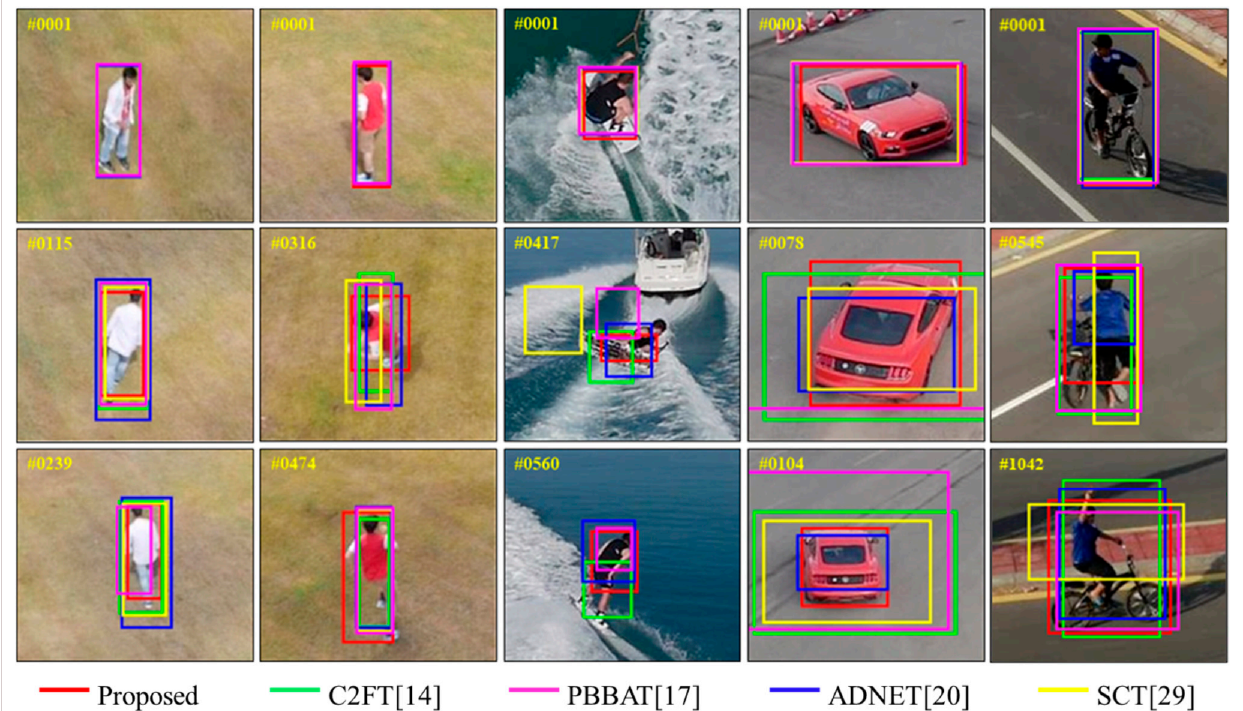
Figure 16. Examples of the UAV datasets tracking results. The first, second, third, fourth, and fifth columns show the challenging image sequences. From left to right are person1, person7, wakeboard4, car18, and bike1,